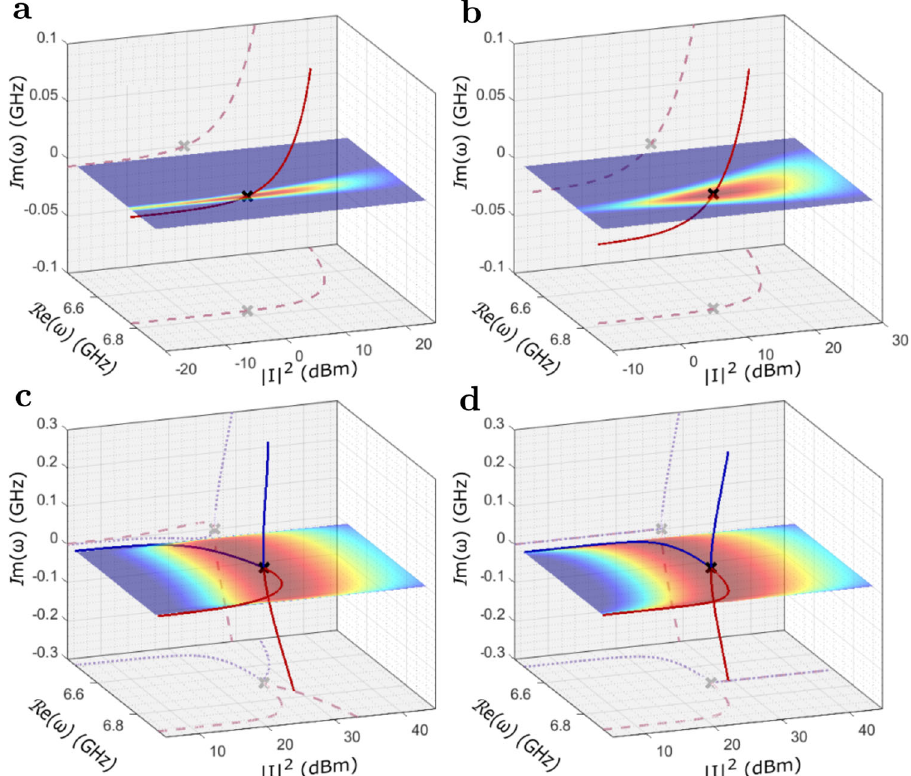
Fig. 3 Complex zeros dependence on the input power for different coupling strength. Trajectories (red and blue solid lines) of the complex zeros ω of the scattering matrix as a function of input power. The dashed and dotted lines are projections of these trajectories on the corresponding plane. The non- linearity Ω = β 0 + β 1 ∣ ψ 0 ∣ 2 with β 0 = (67.74 + 3.00i) × 10 − 3 GHz β 1 = ( − 0.141 + 0.410i) × 10 − 3 GHz mW − 1 . a For two weakly coupled antennas of relative coupling strength κ / ν = 0.23, where ν is the coupling strength inside the semi-in fi nite leads and κ the coupling strength to the non-linear resonator. b For two intermediately coupled antennas of κ / ν = 0.40. c For two perfectly coupled antennas κ / ν = 1. d As bottom left but the real part of the non-linearity is set zero, i.e., no real frequency shift. The absorbance A is reported as a density plot versus the frequency ω and the power P VNA injected by the vector network analyzer (VNA) using the same color scale is in Fig.